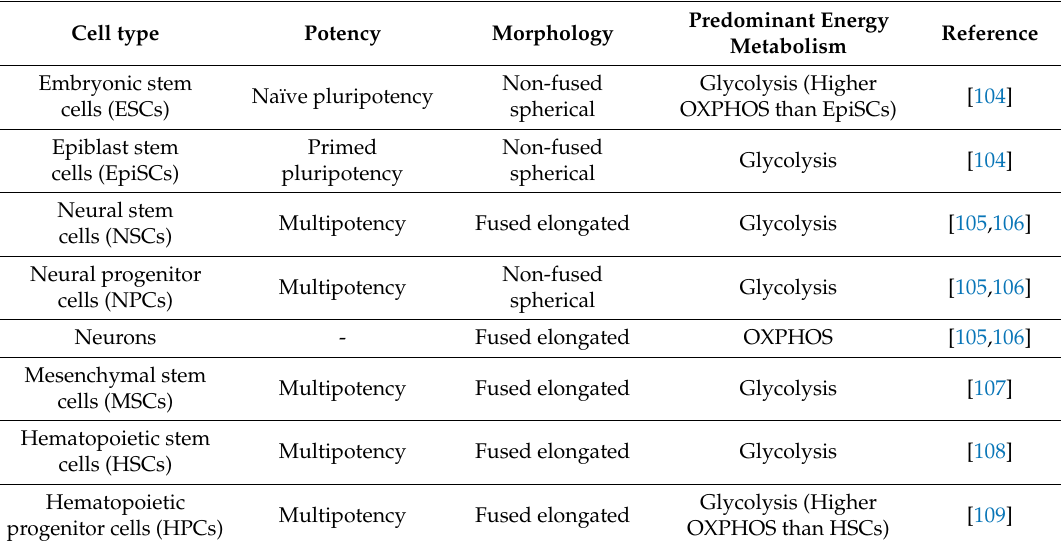
Table 2. Mitochondrial morphology and energy metabolism in various cell